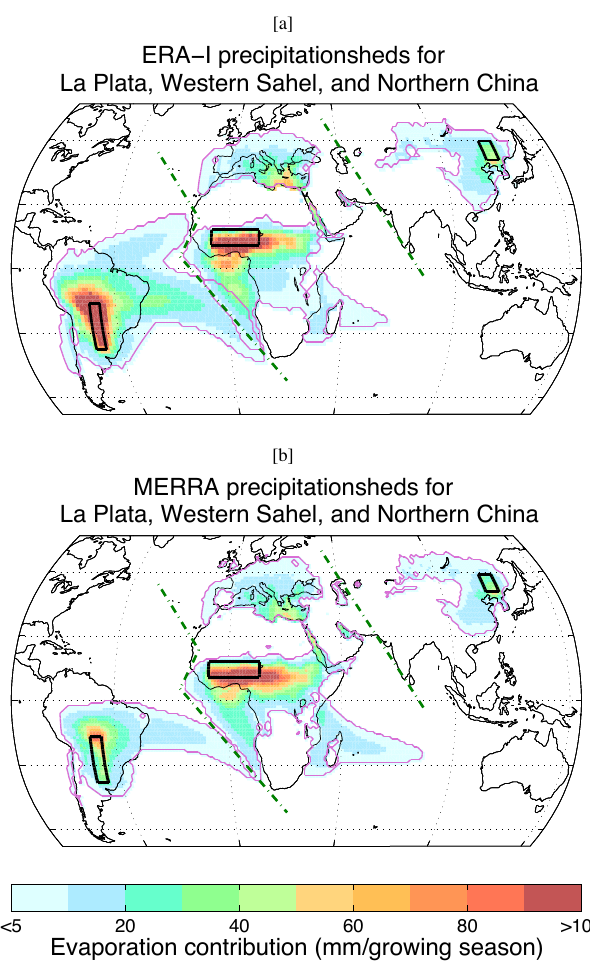
Figure 2. Comparison of mean precipitationshed extents for ERA-Interim (top) and MERRA (bottom), for the period 1980– Fig.2. ComparisonofmeanprecipitationshedextentsforERA-interim(top)andMERRA(bottom),forperiod1980-2011.Linesareincluded 2011. Lines are included to identify the sink region (black box) toidentifythesinkregion(blackbox),the5mmgrowingseason  1 precipitationshedboundary(magentaline),andtoseparatethedifferent precipitationsheds, since the three precipitationsheds do not occur simultaneously (dashed green line). Note that where the 5mm growing the 5mmgrowingseason − 1 precipitationshed boundary (magenta season  1 boundariesfortheWesternSahelandLaPlatabasinoverlap(particularlyintheSouthernAtlantic),thevaluesfortheWesternSahel line), and to separate the different precipitationsheds, since the three aredisplayed,andtheMediterraneansourcesbelongtotheWesternSahel.Valueslessthan5mmareexcludedfromtheprecipitationsheds. precipitationsheds do not occur simultaneously (dashed green line). Note that, where the 5mmgrowingseason − 1 boundaries for the western Sahel and La Plata basin overlap (particularly in the South Atlantic), the values for the western Sahel are displayed, and the Mediterranean sources belong to the western Sahel. Values less than 5mm are excluded from the